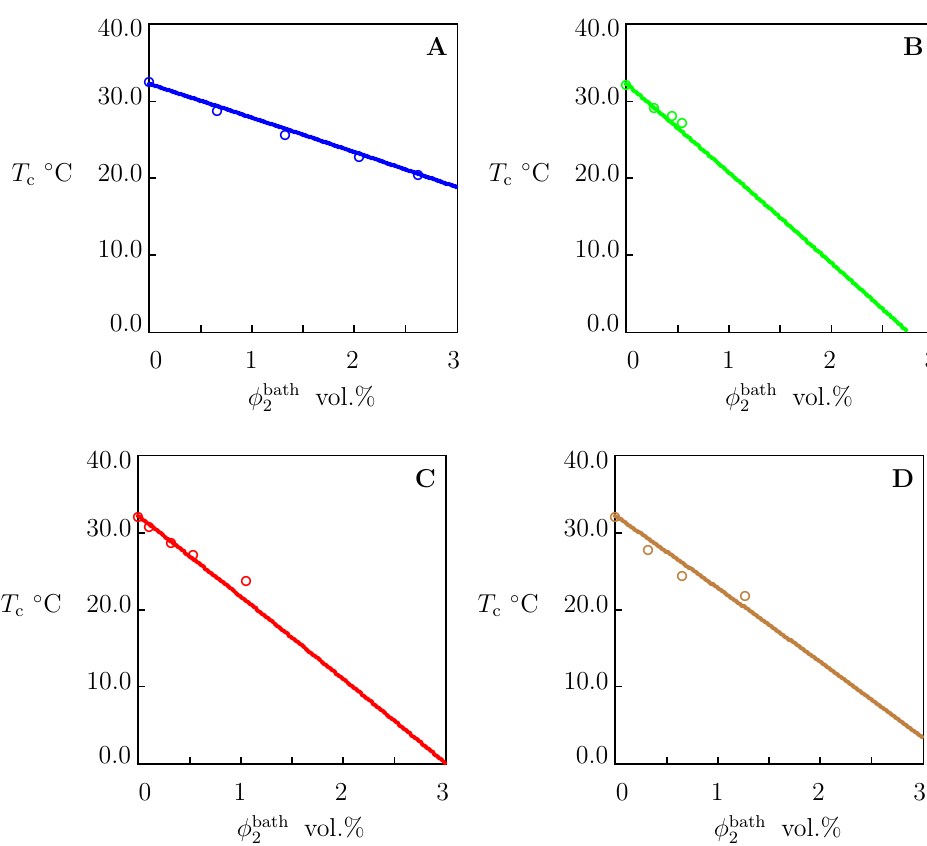
Figure 10. The critical temperature T c versus concentrations of salts in aqueous solutions φ bath Circles: experimental data on PNIPAAm chains [49]. ( A )—NaCl, ( B )—NaH 2 PO 4 , ( C )—Na 2 SO 4 , ( D )—Na 3 PO 4 . Solid lines: predictions of the